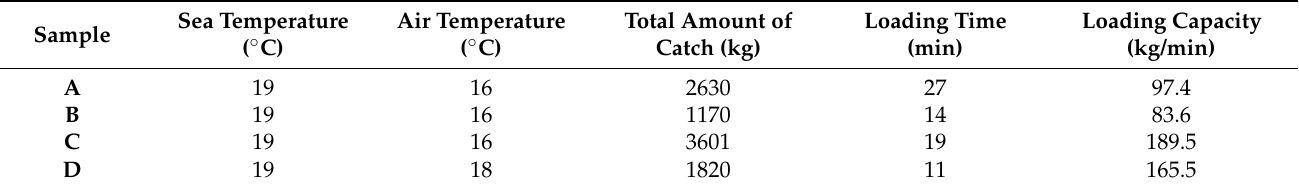
Table 2. Sea and air temperature, total amount of catch, loading time, and loading capacity during collection of samples A and B were handled by the traditional method, and samples C and D were handled by the modified handling method.